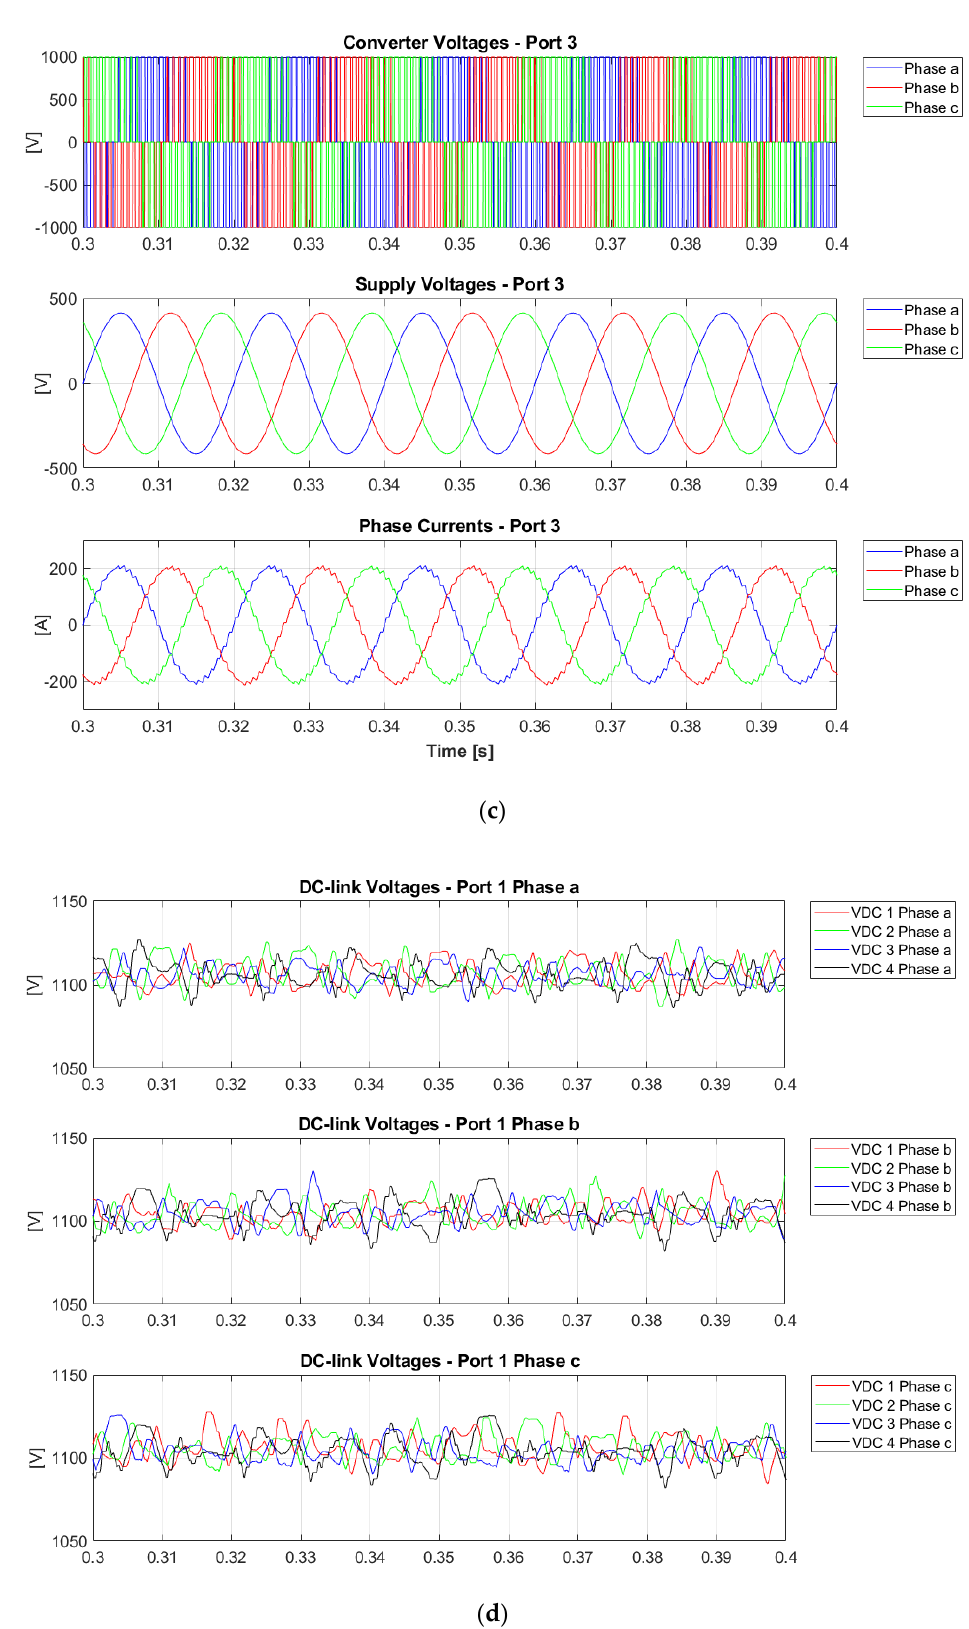
Figure 19. Simulation results: ( a – c ) Converter voltages, supply voltages, and AC currents during operations in area C for Port 1, Port 2, and Port 3; ( d ) DC-Link voltages during operations in area C.